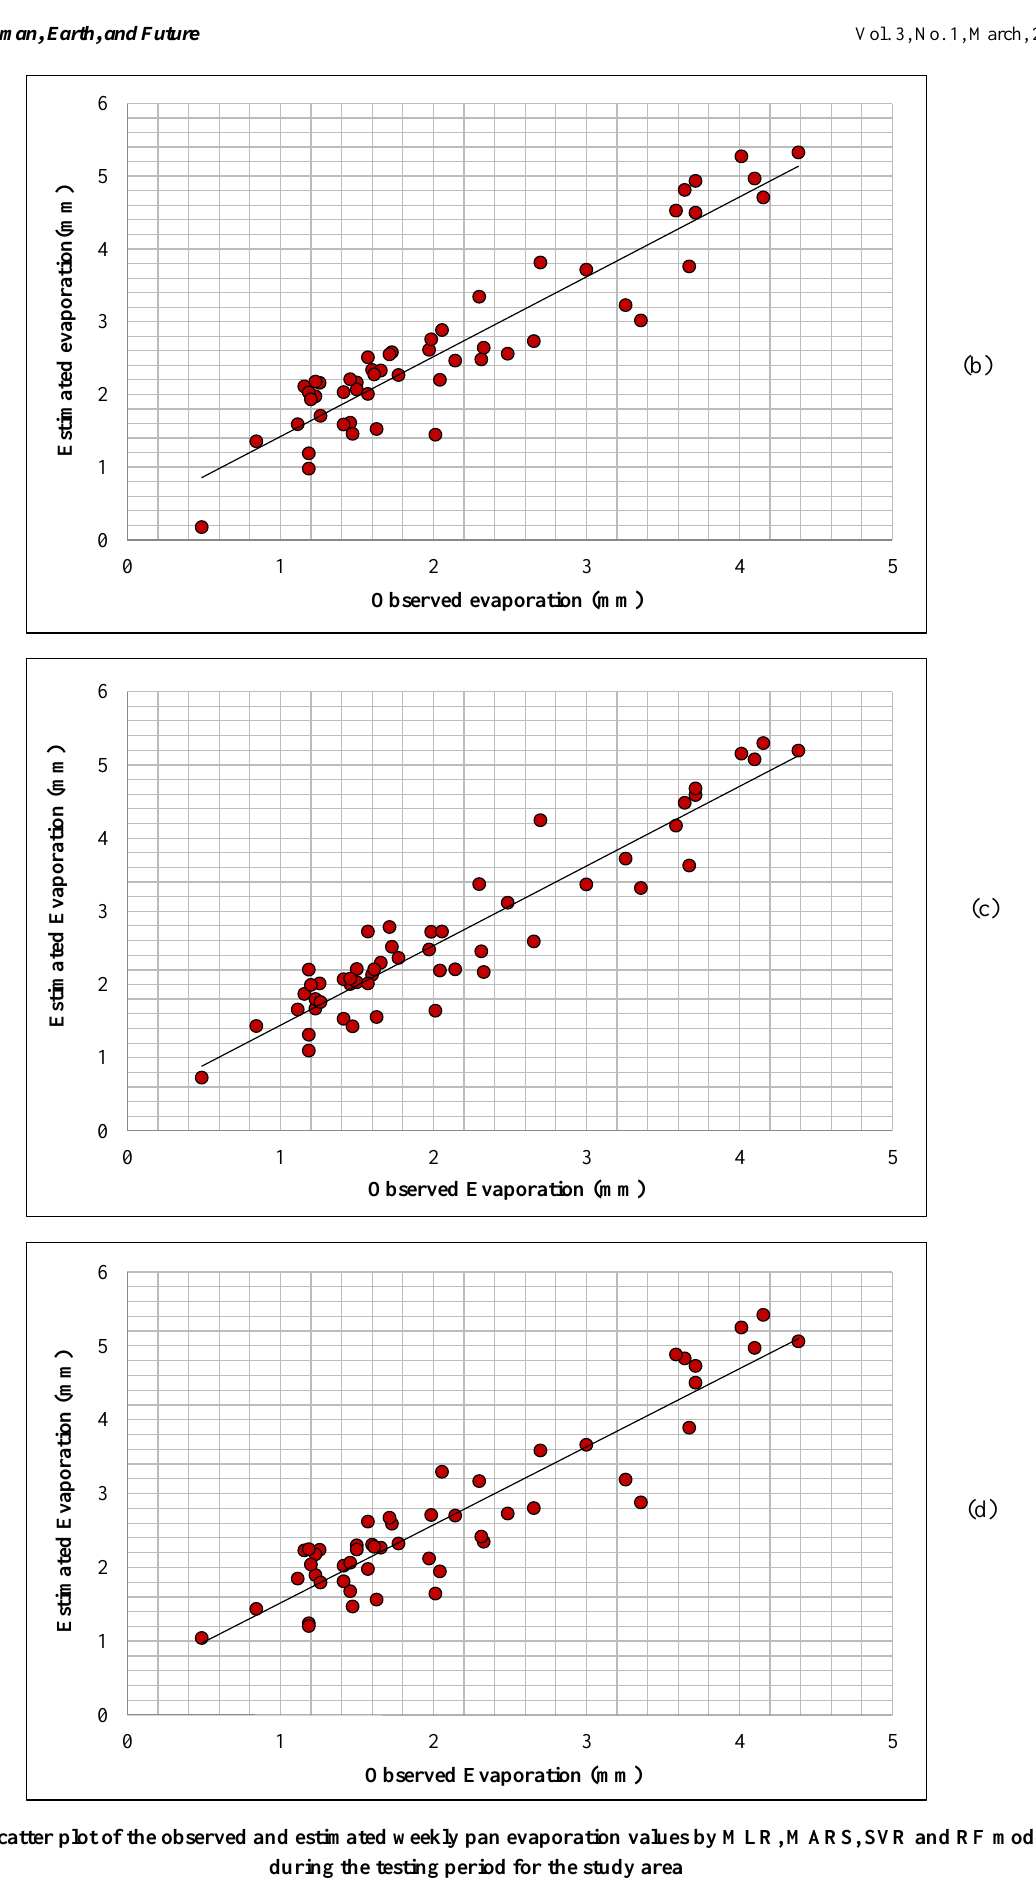
Figure 3. Scatter plot of the observed and estimated weekly pan evaporation values by MLR, MARS, SVR and RF models during the testing period for the study